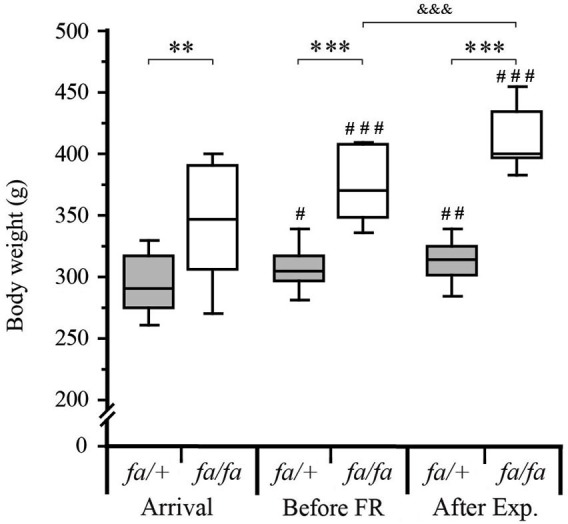
Monitoring of body weight of fa/+ and fa/fa Zucker rats during the experiments. On their arrival, the body weight of the fa/+ and fa/fa Zucker rats (7–8 weeks old), was already significantly different (299 ± 7.2 g vs. 344 ± 11.8 g lean vs. obese respectively; ** P < 0.001). Between their arrival and before food restriction (FR, 10–11 weeks old) the body weight of the two Zucker rats genotype had increased (299 ± 7.2 g to 306 ± 5.7 g for lean; #
P < 0.05 and 344 ± 11.8 g to 372.9 ± 7.4 g for obese; ###
P < 0.001) and the body weight difference between lean and obese rats was more pronounced (*** P < 0.0001). After the experimental procedure (After Exp) corresponding to 2 weeks of FR, the body weight of fa/+ rats stayed significantly different compared to their body weight measured at their arrival (##
P < 0.001) but it was not significantly different compared to those measured before FR (306 ± 5.7 g vs. 312.3 ± 4.4 g; P = 0.1). The fa/fa rats body weight had continued to increase (372.9 ± 7.4 g before FR vs. 412 ± 7.1 g after Exp.; &&&
P < 0.0001). Values are shown as medians ± interquartile range, # compared to the body weight at the arrival of each genotype group the statistical analyses were performed using paired t-test, n = 16 per genotype.